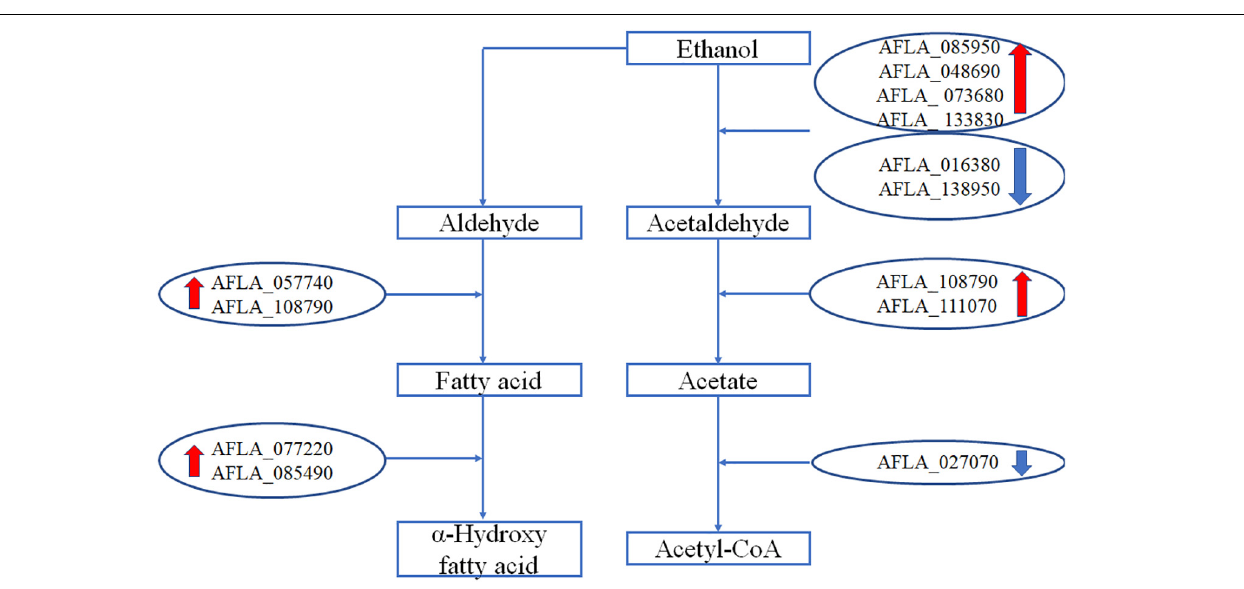
FIGURE 5 | The differential expression of genes involved in metabolism of